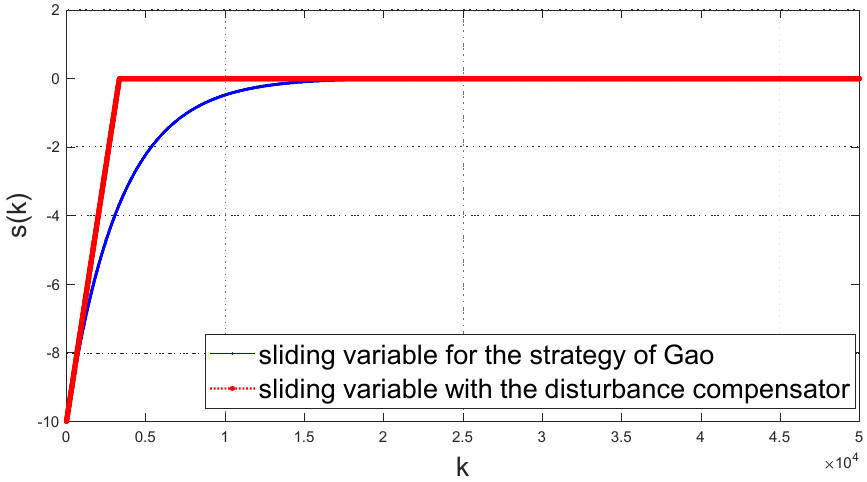
sliding variable for the strategy of Gao sliding variable with the disturbance compensator